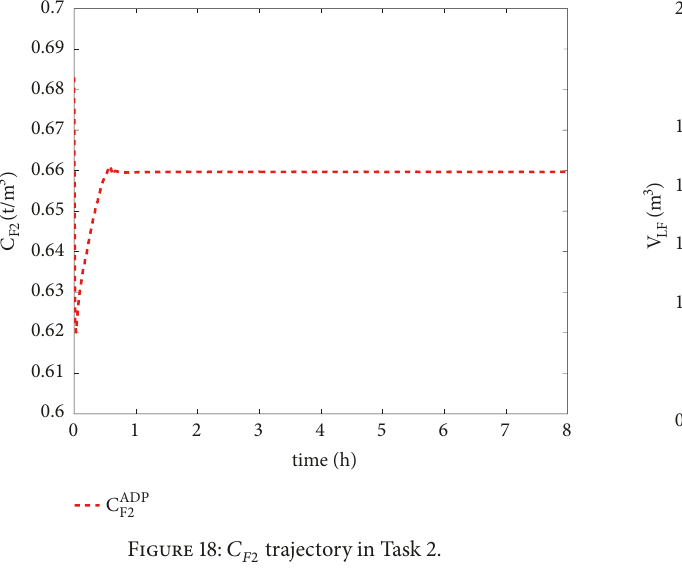
Figure 18: 𝐶 𝐹2 trajectory in Task 2.